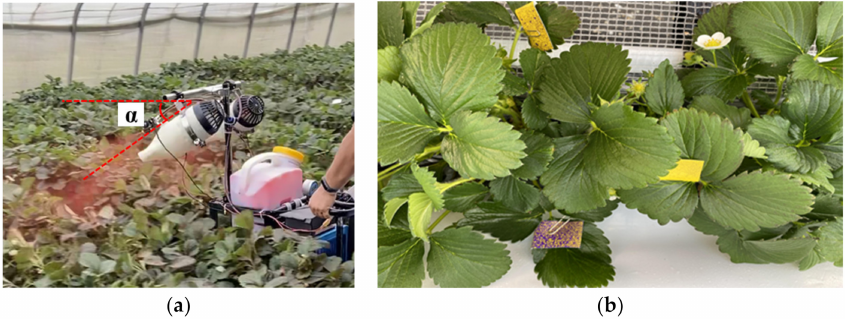
Figure 5. Field operation and deposition effects of the ASS: ( a ) application in the greenhouse, where α is the angle of the air-assisted spray unit relative to the ground; ( b ) condition of the WSP after